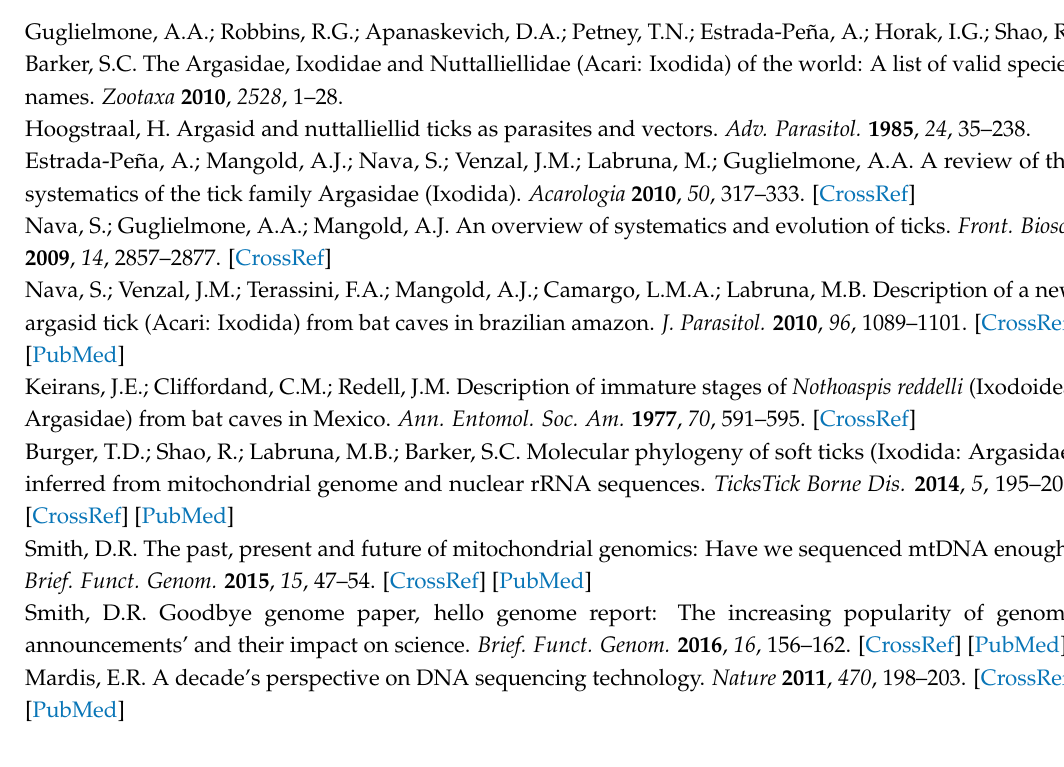
Figure S1: Distance matrices and identity of the complete mitogenome of tick belonging to Argasidae family, Table S1: Gene order, gene position, intergenic regions, gene overlap and DNA transcription direction strand in the mitochondrial genome of Nothoaspis amazoniensis , Table S2: Cleavage sites for restriction enzymes in the mitogenome of Nothoaspis amazoniensis , Table S3: Gene overlaps for the mitogenome of Nothoaspis amazoniensis , Table S4: Non-coding intergenic regions in the mitogenome of Nothoaspis amazoniensis , Table S5: Distance matrices and identity of the complete mitogenome of tick belonging to Argasidae